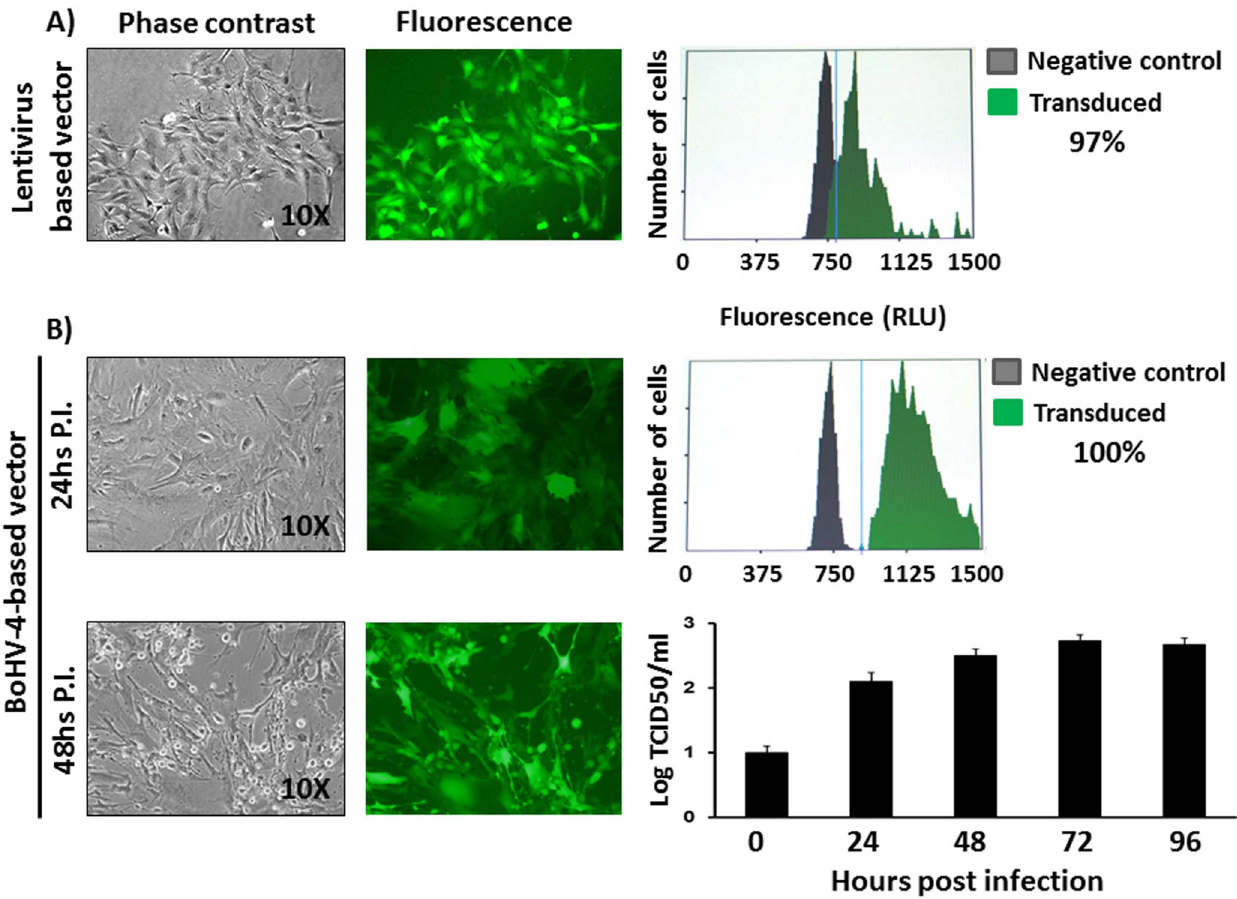
Figure 6. ASSC transduction. Representative phase contrast and fluorescence images (10x) of ASSCs transduced by a self-inactivating replicating incompetent third generation lentiviral vector at 48 h post transduction (A) and a replicating competent BoHV-4-based vector (B) at different times: 24 and 48 h post infection (P.I.). Efficiency of transduction was measured by cytometry. The titres of BoHV-4-based vector were examined by determining the numbers of cell free viruses through time (expressed as log TCID 50 /ml). The data presented are the means 6 standard errors of triplicate measurements ( P . 0.05 for all time points as measured by Student’s t test).